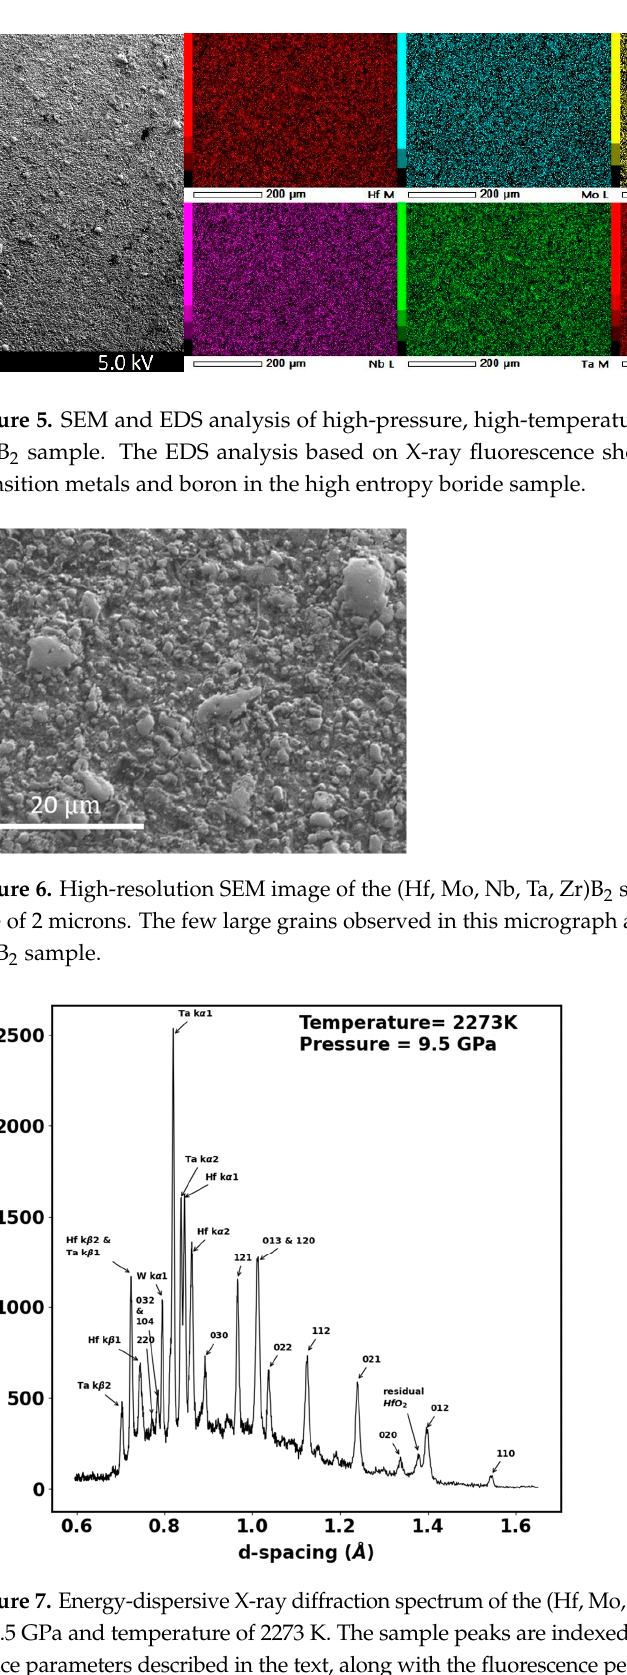
Figure 8. The 2nd Order Birch Murnaghan equation of state (BM EoS) in Equation (1) was used with the thermal expansion model [21,22] shown in Equation (2) to extract the bulk modulus ( K 0 ), dK / dT , and the volumetric thermal expansion coefficient α . 𝑃(cid:4666)𝑉(cid:4667) (cid:3404) (cid:2871) (cid:2870) 𝐾 (cid:2868) (cid:4674)𝑥 (cid:3123) (cid:3119) (cid:3398) 𝑥 (cid:3121) (cid:3119) (cid:4675)(cid:4670)1 (cid:3397) (cid:2871) (cid:2872) (cid:4666)𝐾 (cid:2868)(cid:4593) (cid:3398) 4(cid:4667)(cid:4672)𝑥 (cid:3118) (cid:3119) (cid:3398) 1(cid:4673)(cid:4671) (1) 𝑉 (cid:2868)(cid:3021) (cid:3404) 𝑉 (cid:2868)(cid:2868) exp (cid:4678)𝛼 (cid:2868) (cid:3435)𝑇 (cid:3398) 𝑇 (cid:3045)(cid:3032)(cid:3033) (cid:3439) (cid:3397) (cid:2869) (cid:2870) 𝛼 (cid:2869) (cid:3435)𝑇 (cid:2870) (cid:3398) 𝑇 (cid:3045)(cid:3032)(cid:3033)(cid:2870) (cid:3439) (cid:3397) 𝛼 (cid:2870) (cid:3436) (cid:2869) (cid:3021) (cid:3398) (cid:2869) (cid:3021) (cid:3293)(cid:3280)(cid:3281) (cid:3440)(cid:4679) (2) In Equation (1), x = V 0 /V , K 0 is the bulk modulus, and K 0 ’ is the first pressure deriva- tive. For Equation (2), the temperature-dependent volumetric thermal expansion α is de- scribed by coefficients α 0 , α 1 , α 2 as α = α 0 + α 1 T + α 2 T − 2 . The fit to P-V-T data shown in Figure 8 yields information on the thermoelastic properties of the synthesized HEB sample. Us- ing the ambient pressure unit-cell volume measured earlier V 0 = 26.882 Å 3 , the fit resulted in a bulk modulus K 0 = 276 GPa at ambient temperature with a fixed value of K 0 ’ = 4. The fitted value of the temperature derivative of bulk modulus is dK/dT = − 0.090 GPa/K. Ther- mal expansion coefficients were calculated to be α 0 = − 1.533 × 10 − 5 K − 1 , α 1 = 4.071 × 10 − 8 K − 2 , and α 2 = 4.60 K, with the volumetric thermal expansion expressed as α = α 0 + α 1 T + α 2 T − 2 in the temperature range between 300 and 2300 K.